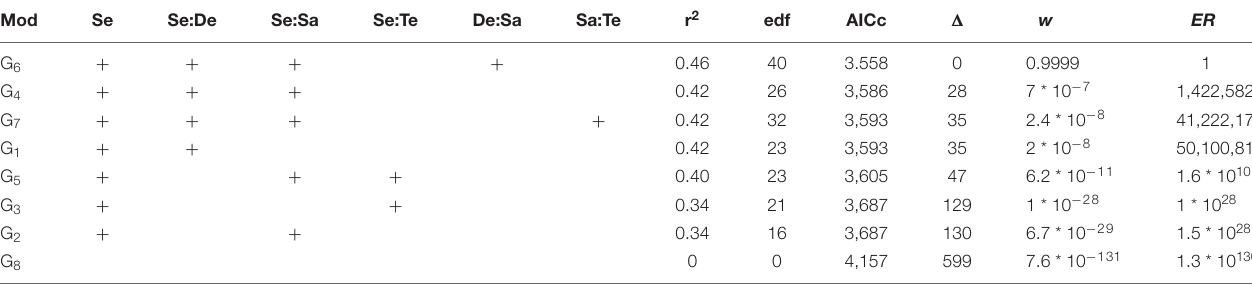
TABLE 2 | Summary of information-criteria-based model selection for the species richness (S).